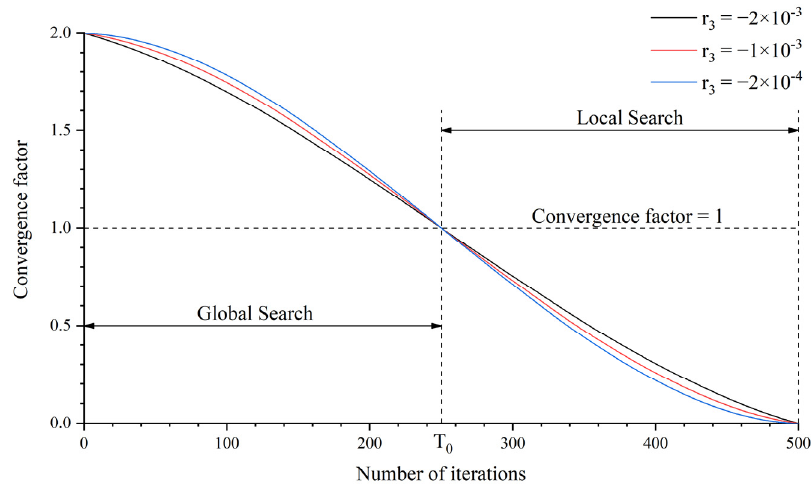
Figure 1. Nonlinear convergence factor based on third-degree polynomials.